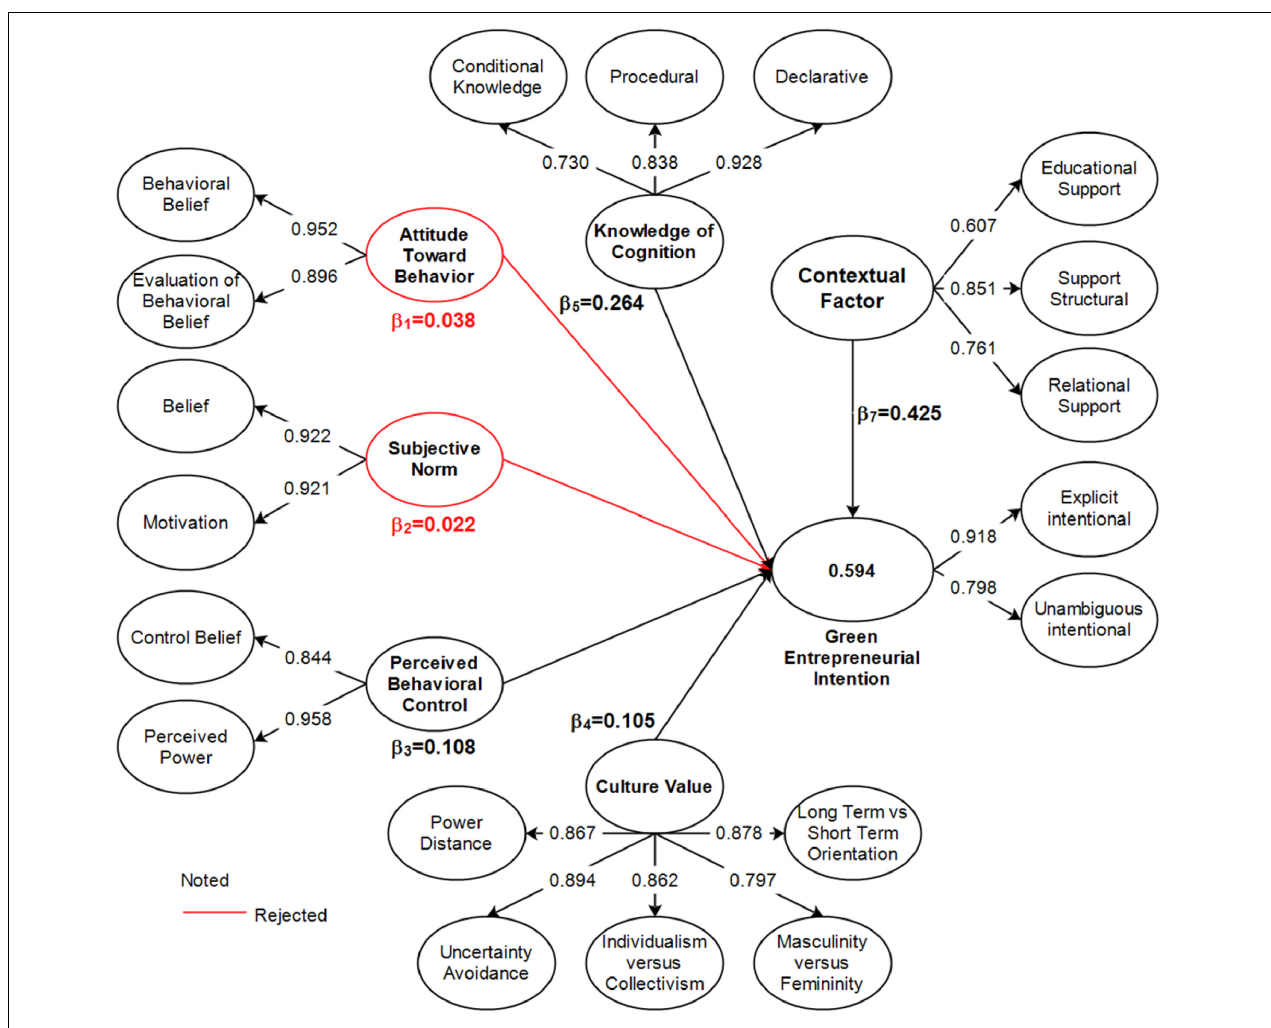
FIGURE 2 | Structural model before moderation.